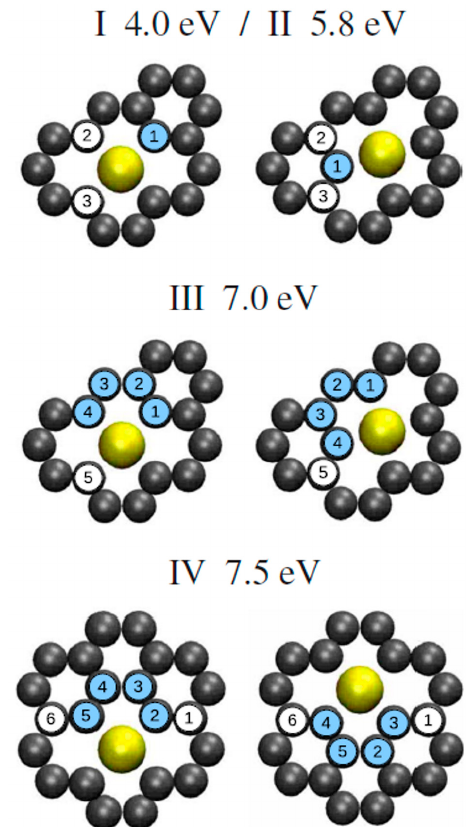
Figure 8. Au in double vacancies in graphene: simulations of different diffusion paths (path I, II, III, IV) of the Au atom (yellow sphere), whereas the blue dots indicate the C atoms which change position as result of the Au atom jump. In addition, each path is accompanied by the estimated diffusion barrier for the Au jump. Reproduced from Reference [98] with permission from the American Institute of Physics.